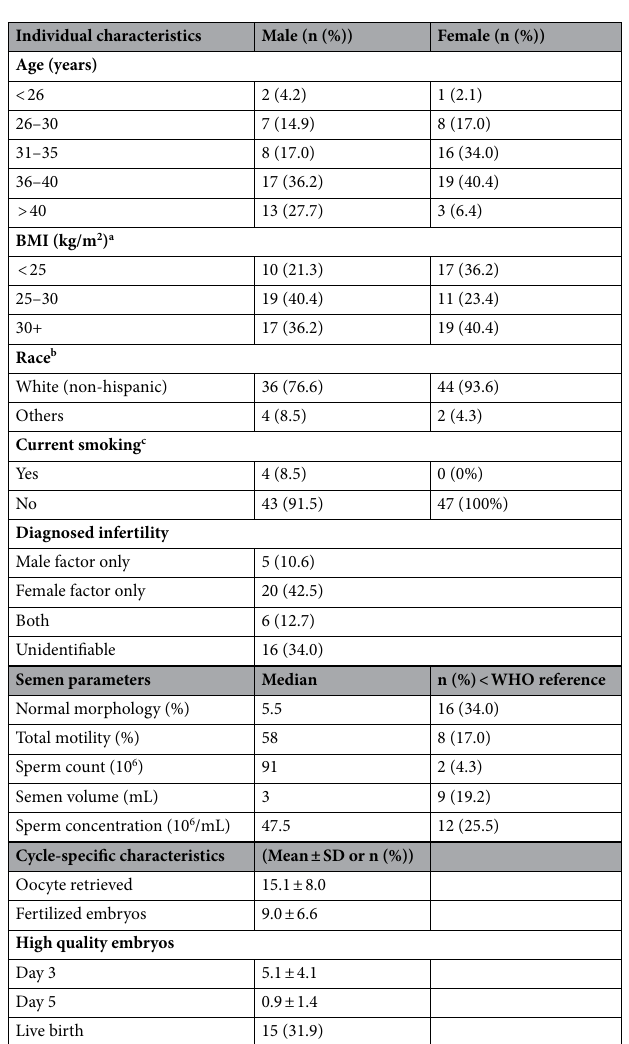
Table 1. Characteristics of SEEDS participants (n = 47). a Missing male BMI data (n = 1). b Missing race data (Male, n = 7 and female, n = 1). c Males based on urinary cotinine and females based on